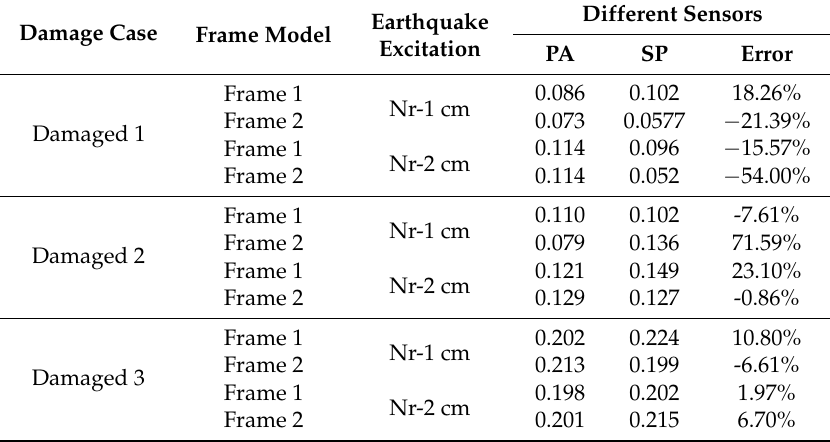
Table 7. The relative wavelet entropy (RWE) index for different